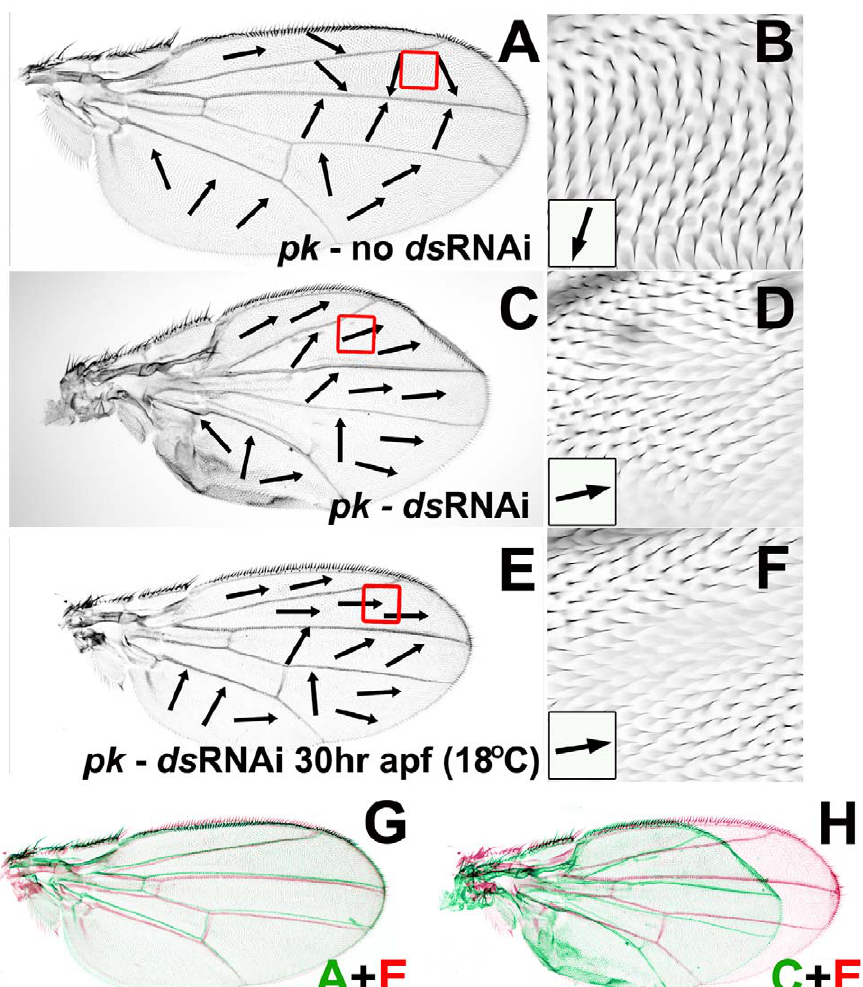
Figure 8. Reduced ds expression can modify pk pk hair polarity without affecting wing morphogenesis. All micrographs show dorsal wing surface of MS1096-Gal4/ + ; pk 30 , UAS-ds(IR)/pk 30 , tubP-GAL80ts female flies. Black arrows indicate local hair polarity. (A) Wing from fly cultured at 18 u C. (B) Enlargement of anterior region outlined by red box in (A). (C) Wing from fly cultured at 30 u C. (D) Enlargement of anterior region outlined by red box in (C). (E) Wing from fly cultured at 18 u C then shifted to 30 u C at 30 hours a.p.f. (F) Enlargement of anterior region outlined by red box in (E). (G) Wing from (A) rescaled, colored green and overlaid on wing (E) colored red. (H) Wing from (C) rescaled, colored green and overlaid on wing (E) colored red.